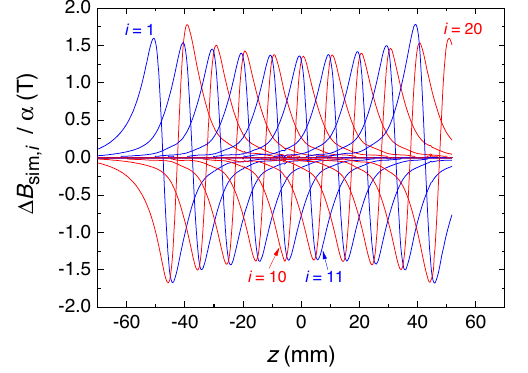
FIG. 5. Response of B calculated from the change in B changed from 0.5 to 0.75 ( α ¼ 0 . 25 ) for B ¼ 3 T. The blue lines are for the upper (odd i ) bulks B s; end and the red lines are for the lower (even i ) bulks.